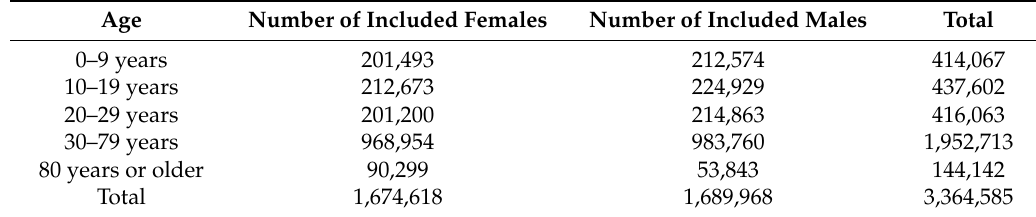
Table 1. Number of included females and males by age group.